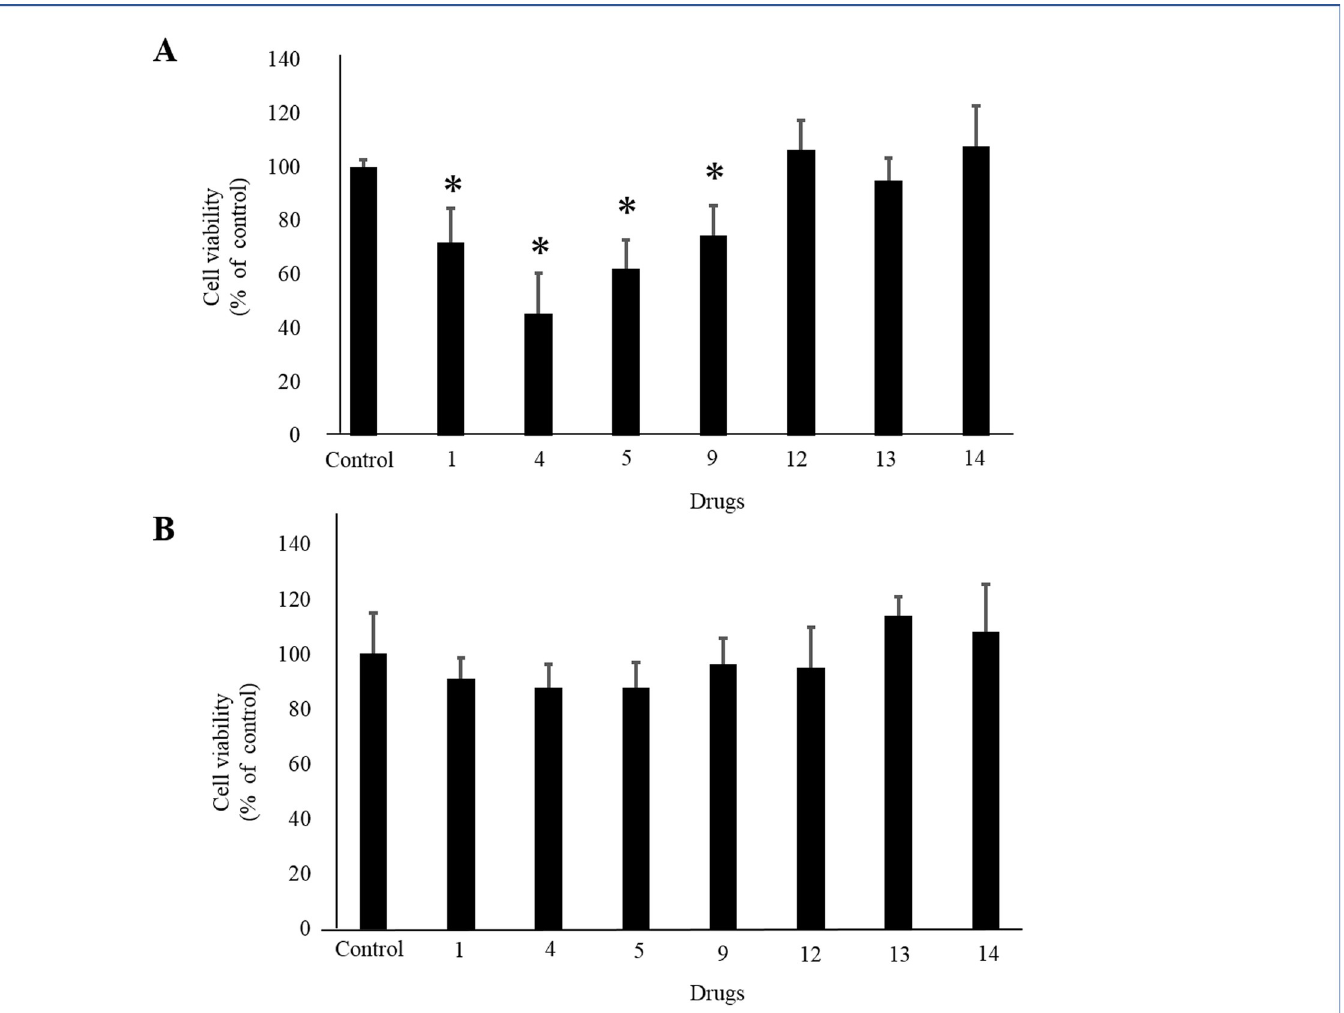
Fig 2. Effect of selected Kampo drugs on the viability of HUVECs. A : The MTS assay with one of 7 selected drugs. B : The CCK-8 assay with one of 7 selected drugs. � indicates P < 0.05. 1: Kakkonto; 4: Anchusan; 5: Hachimijiogan; 9: Saikokaryukotsuboreito; 12: Shoseiryuto; 13: Shofusan 14: Tokishakuyakusan. HUVECs, human umbilical vein endothelial cells; MTS, 3-(4,5-dimethylthiazol-2-yl)-5-(3-carboxymethoxyphenyl)2-(4-sulfophenyl)-2H-tetrazolium inner salt; CCK, Cell Counting Kit.